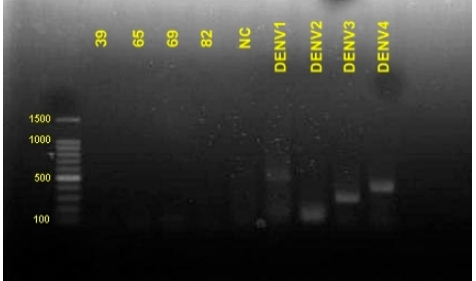
Figure 3. NS1 serological test of positive dengue antibodies samples.